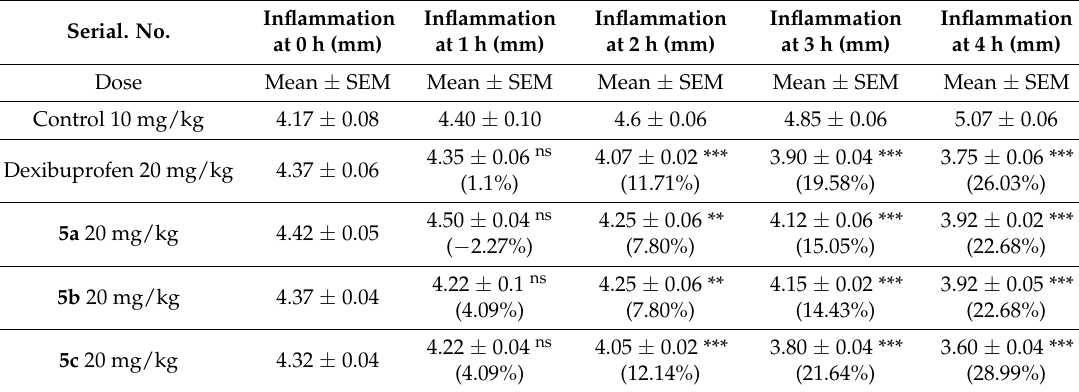
Table 1. Effect of mutual prodrugs ( 5a – c ) in carrageenan induced edema (mm) in mice. Serial.